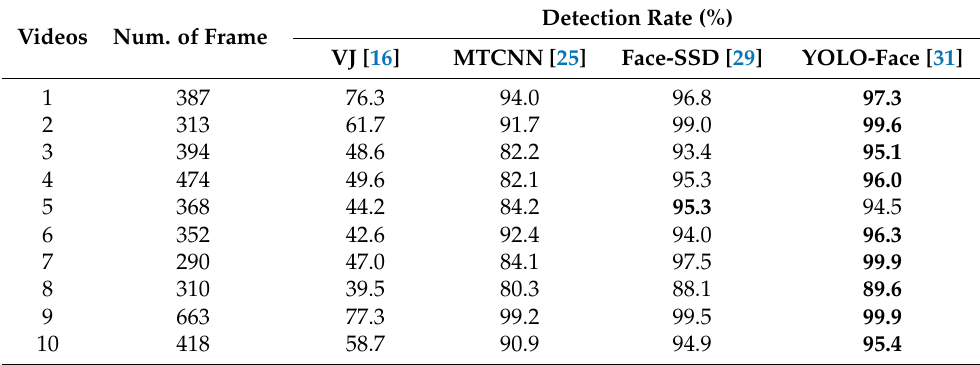
Table 4. Accuracy of the different face detection models on the Honda/UCSD video dataset. Videos Num. of Frame